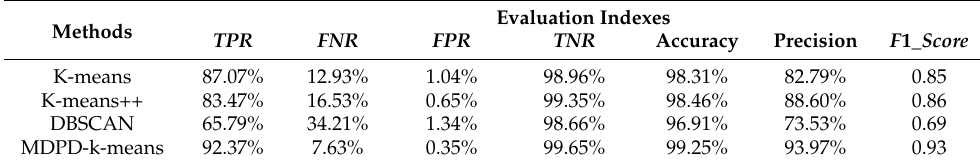
Table 5. Comparison of evaluation indexes of 4 clustering